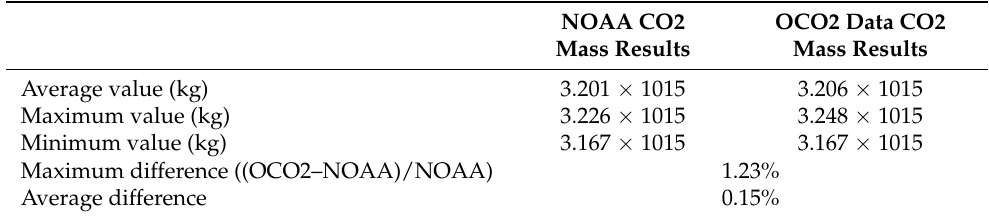
Table 2. Comparison of the global atmospheric carbon dioxide mass using NOAA data and OCO2 data,